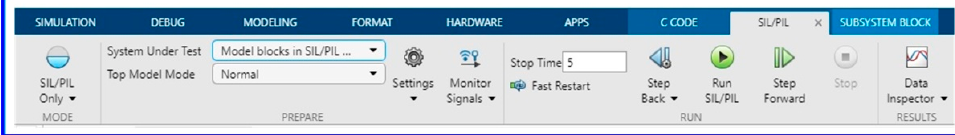
Figure 27. SIL/PIL manager settings for the control algorithm testing. Figure 28. SIL/PIL manager settings for the control algorithm